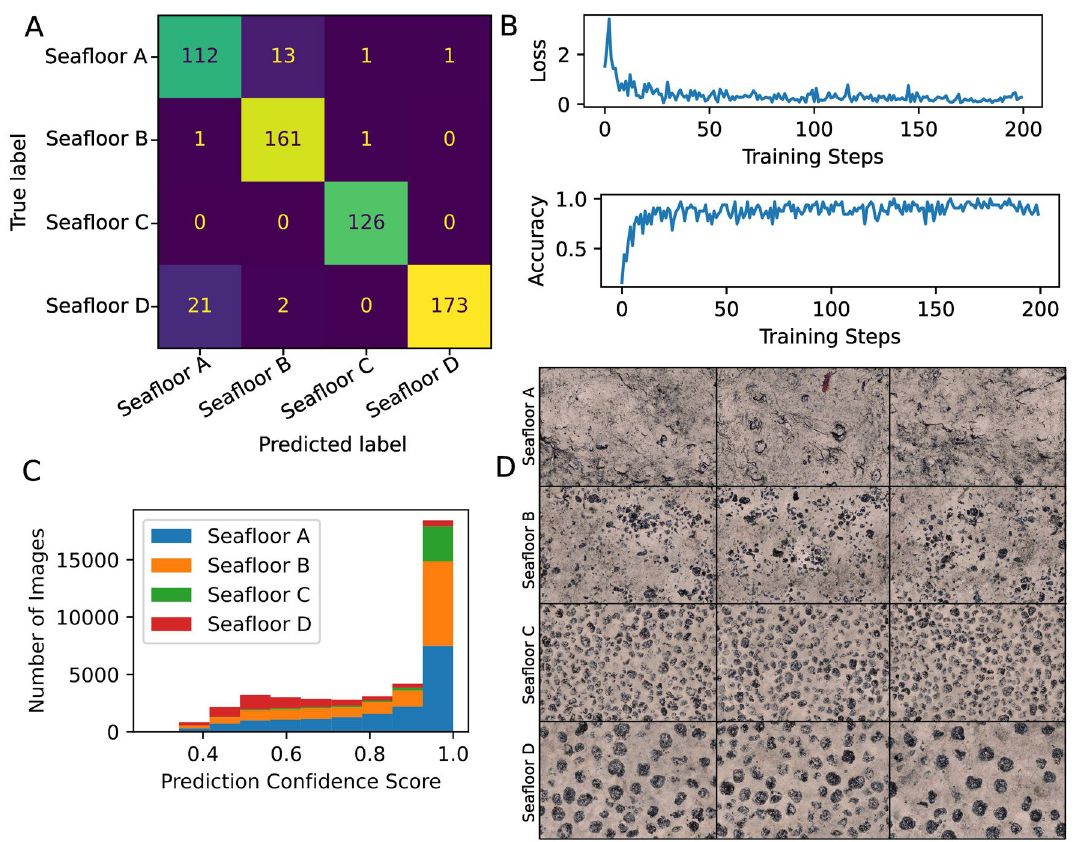
Figure 5. ( A ) Confusion matrix for supervised classifier performance evaluation. ( B ) Loss and accuracy curves used to monitor progress of model training. ( C ) Distribution of prediction confidence scores for each seafloor class. ( D ) Examples of classifier predictions for each seafloor